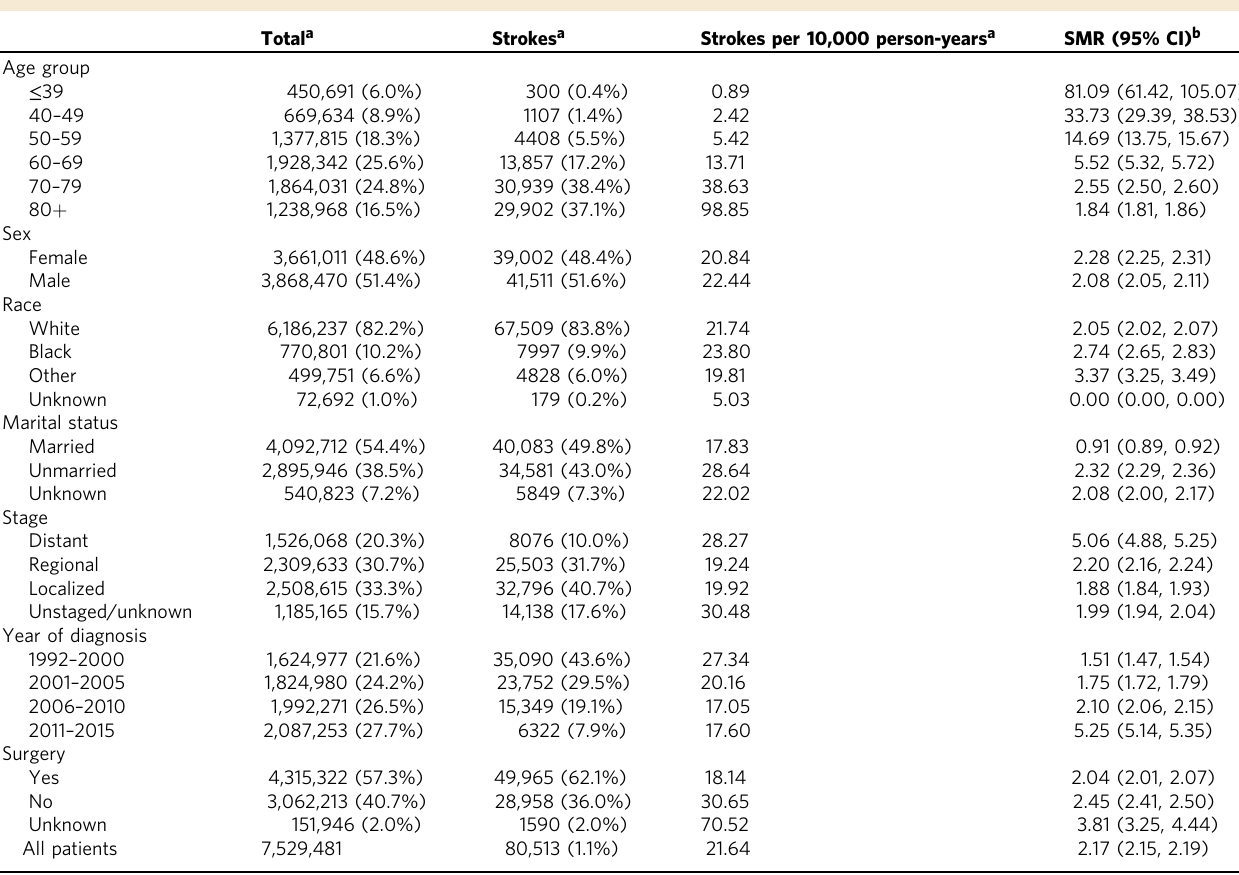
Table 1 Standardized mortality ratios of stroke among cancer patients Total a Strokes a Strokes per 10,000 person-years